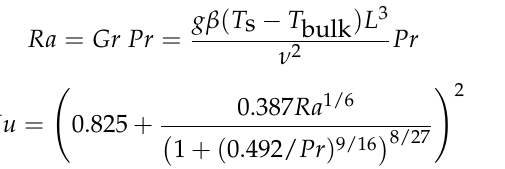
Figure A2. The thermal resistor network used to model the fuel tank.